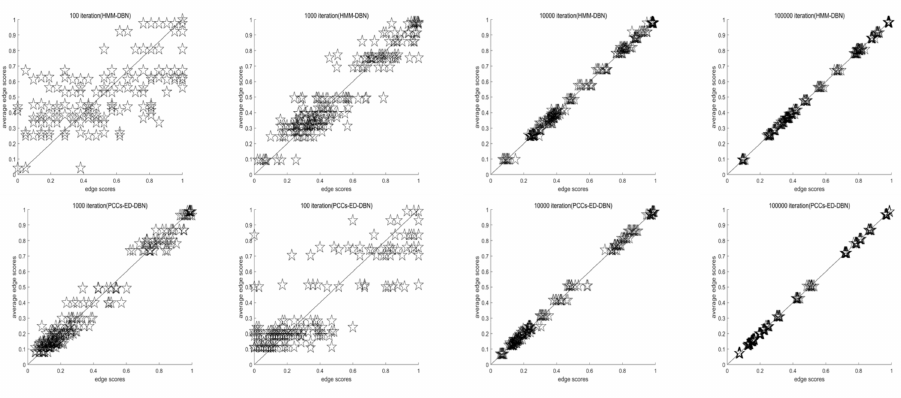
Figure 5. Saccharomyces cerevisiae edge convergence scatter plot under HMM-DBN and PCCs-ED-DBN.